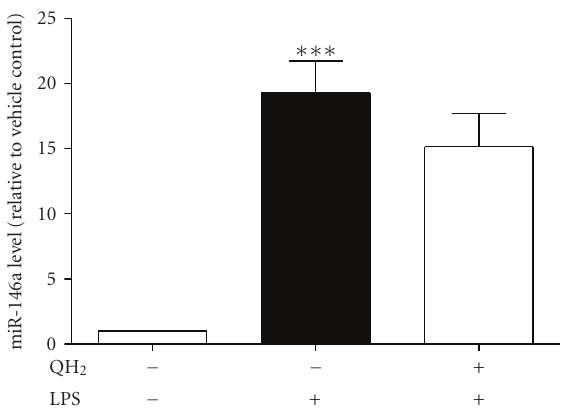
Figure 2: E ff ect of ubiquinol-10 on LPS-induced miR-146a expres- sion in THP-1 cells. THP-1-cells were preincubated without ( − ) or with (+) 10 μ M ubiquinol-10 for 24hours. Afterwards, cells were treated without ( − ) or with (+) 1 μ g LPS/mL for 4hours. After this treatment, total RNA was extracted, converted to cDNA and miRs were assayed by TaqMan-based qRT-PCR. Observed expression levels of miRs in the respective treated cells were normalized to the corresponding levels of the endogenous control (snoRNA202). Data (two-sided t -test) are means ± SEM of three biological experiments performed in quadruplicate. ∗ P < . 05 versus unstimulated cells. ∗∗∗ P < . 001 versus unstimulated cells.